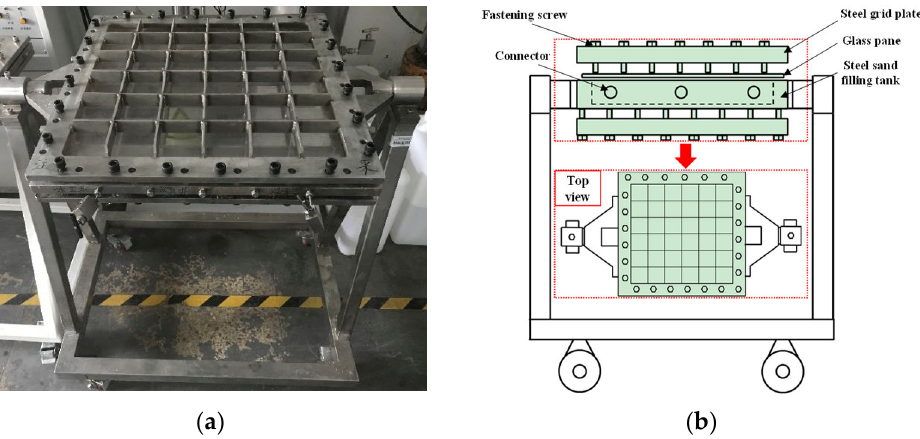
Figure 2. Schematic diagram of plate visual physical device; ( a ) physical diagram of the two-dimensional flat model; ( b ) theoretical diagram of the two-dimensional flat model.